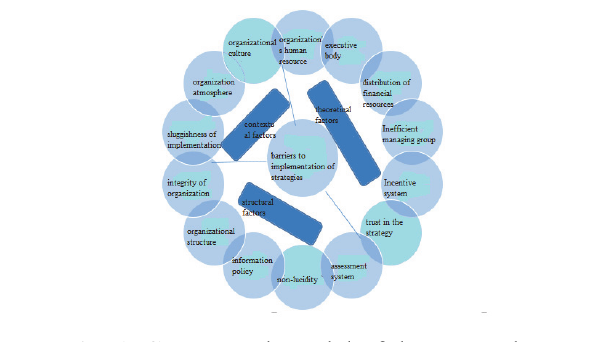
Fig. 1. Conceptual Model of the